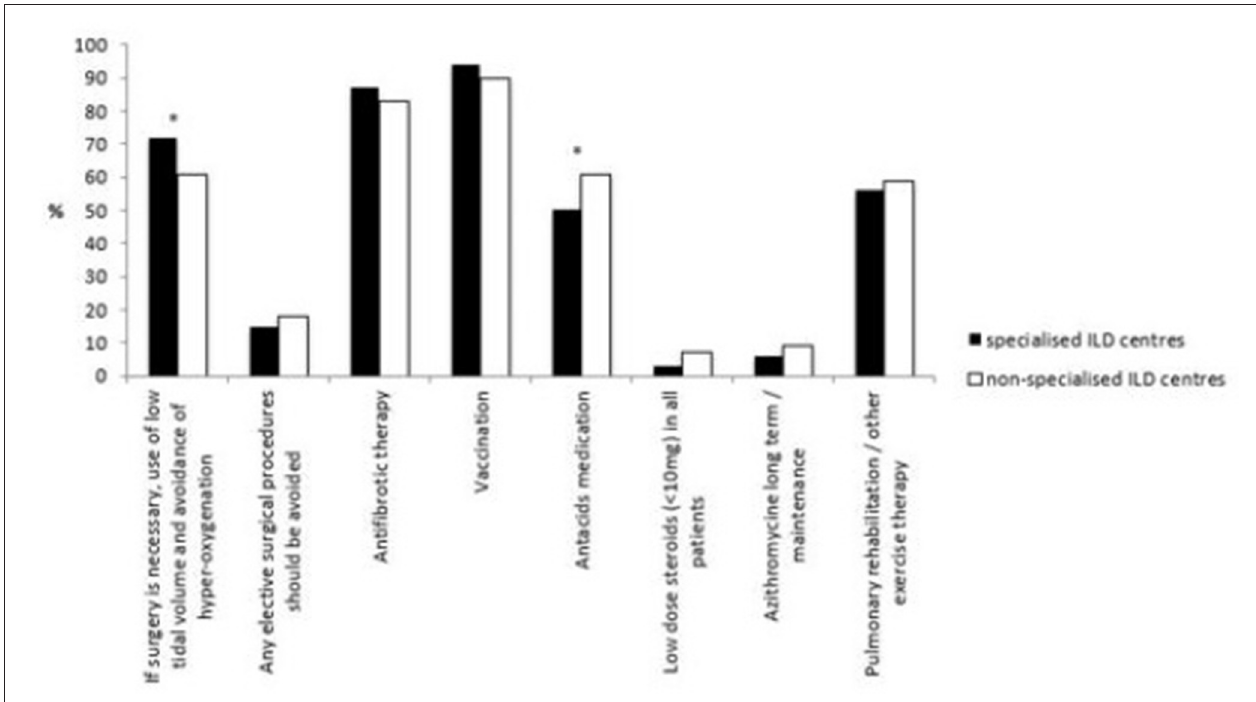
FIGURE 6 | Different preventive strategies in AE-IPF in specialised and non-specialised ILD centres. Statistically significant differences are labelled with a * (p-value = <